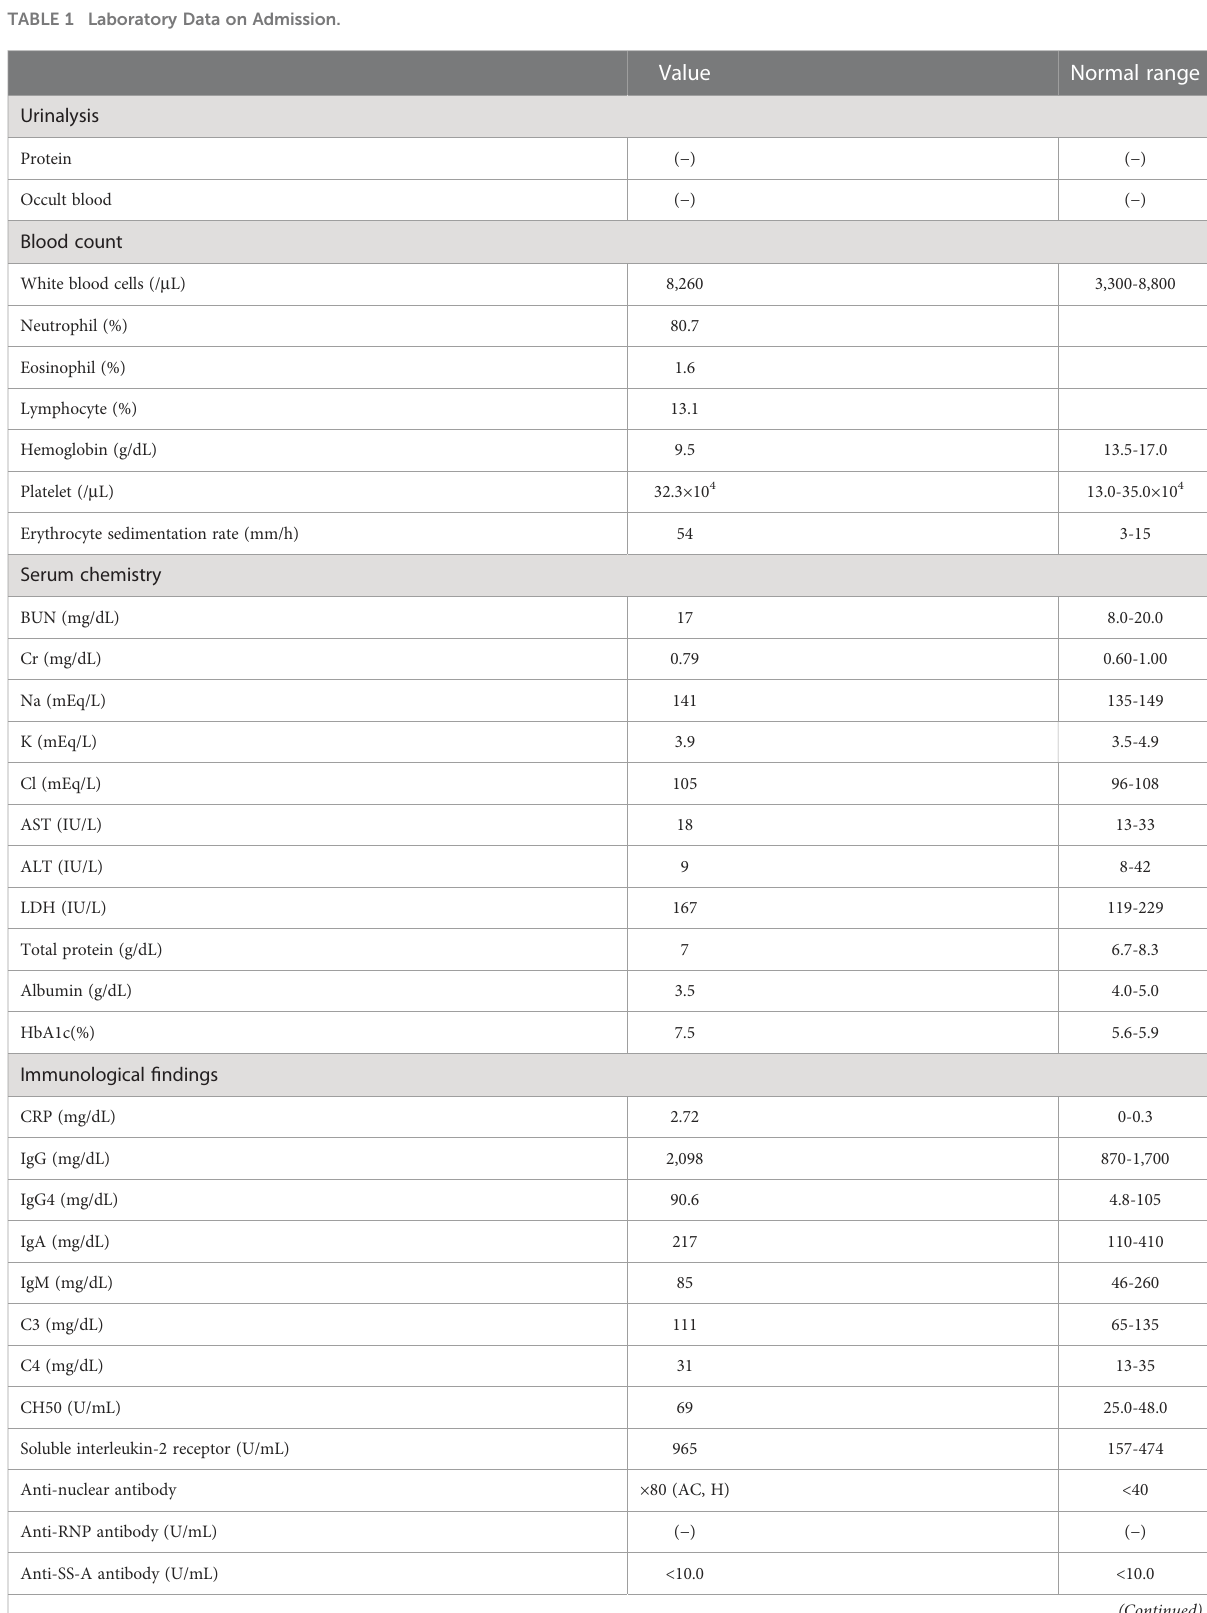
TABLE 1 Laboratory Data on